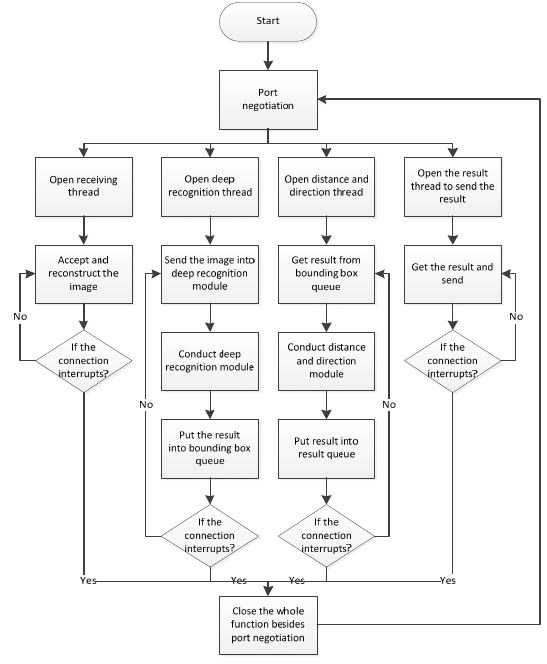
Figure 8. Software process of the server.